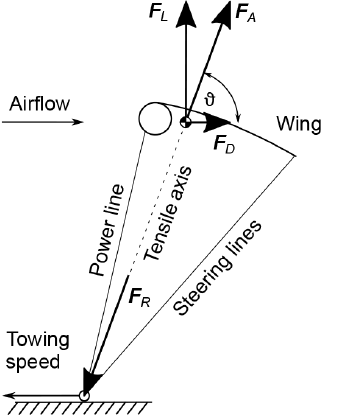
Figure 2. Schematic side view of the tow test with the wing in steady-state equilibrium and effect of gravity neglected, i.e., m g =